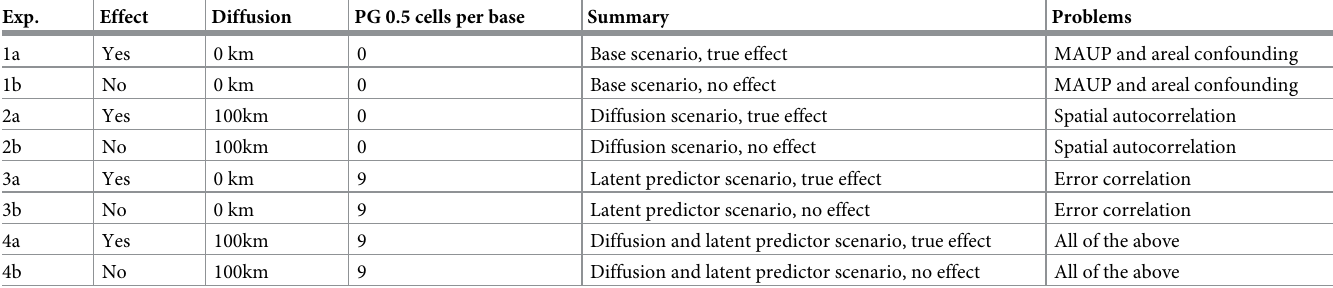
Table 2. Overview of the eight event-generating processes run for all countries. In each experiment, 100 datasets were generated.